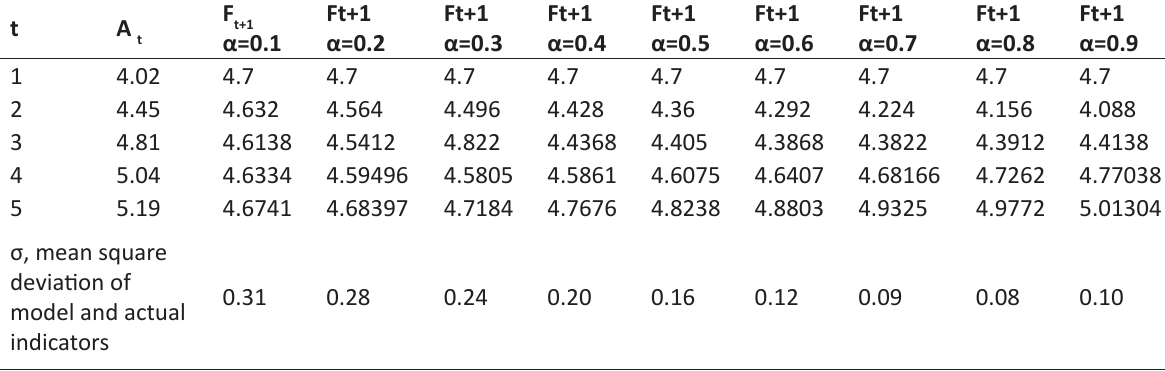
Table 6. Mean square deviations of model and actual indicators in experimental group in May 2016.